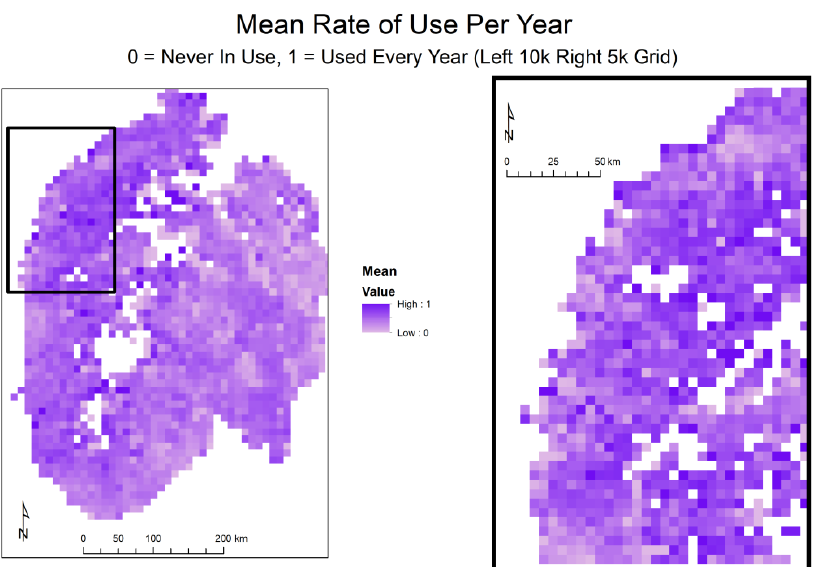
Figure 3. Two examples illustrating the metric “Average”, i.e., the mean number of years in use. 0 is never in use, 1 is used every year. The map on the left shows southern parts of Norway, while the figure on the right shows the map in the frame with higher resolution.